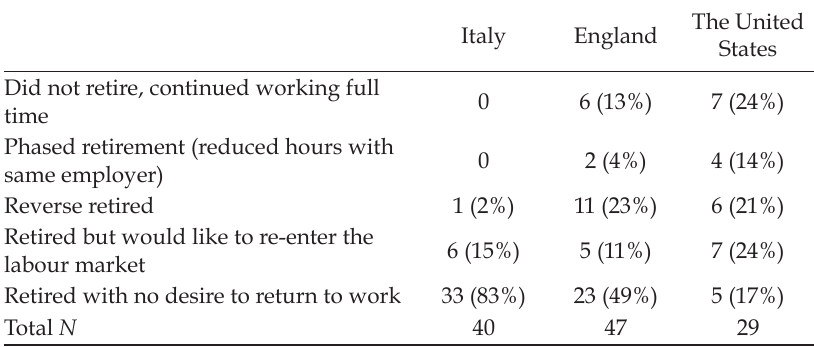
Table 2. Retirement trajectory and aspirations – outcomes by wave